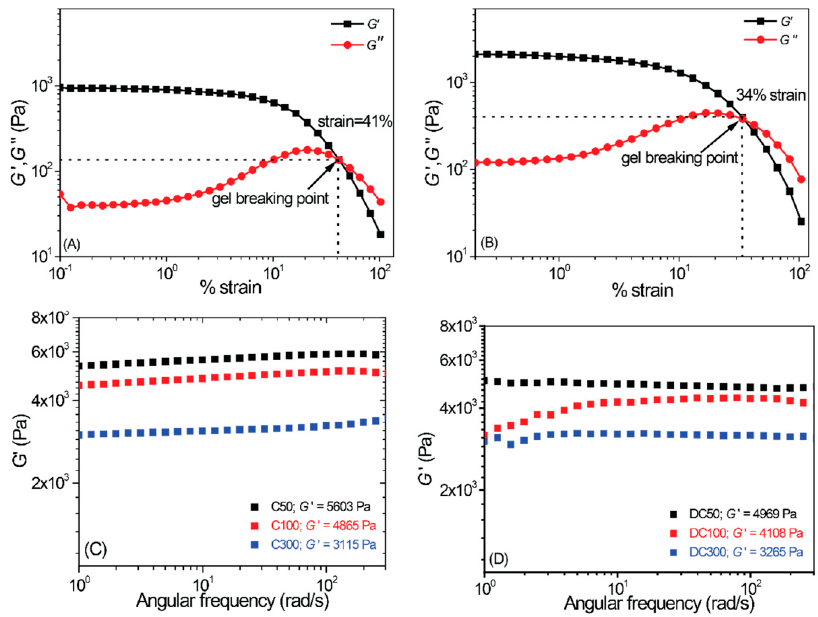
Figure 3. Storage modulus (G´) and loss modulus (G´´) on strain sweep with the ( A ) C200 organogel and ( B ) DC200 hydrogel. Storage modulus G´ versus angular frequency (strain: 2.0%) of various ( C ) organogels and ( D ) hydrogels with different Ac-glu-HEMA/DEGDMA ratios.